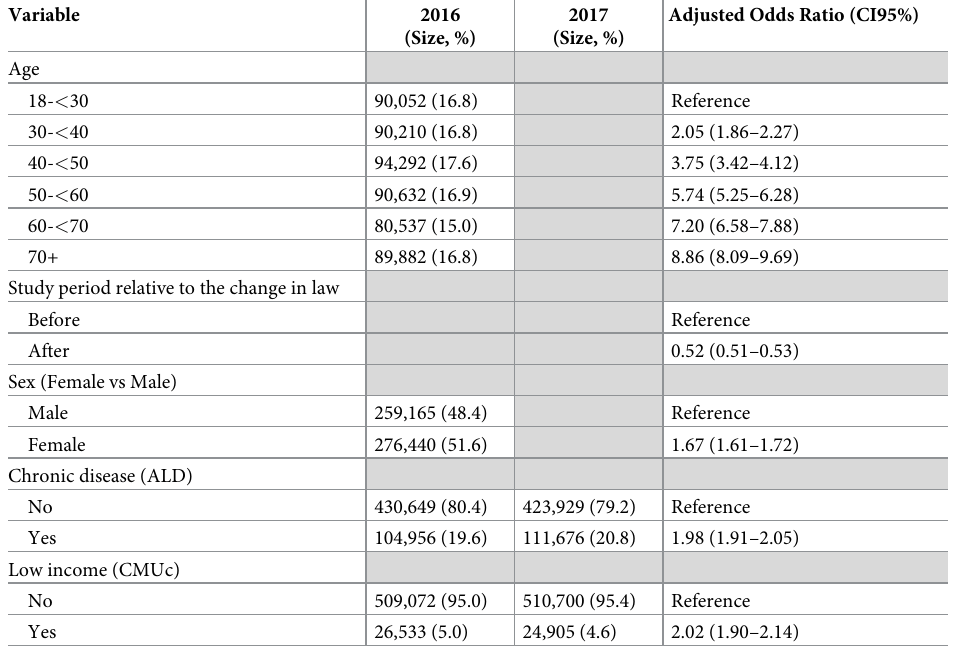
Table 3. Results of the multiple logistic regression on patients present in both periods and aged 18 or over in 2016 (N = 535,605). Being a consumer is